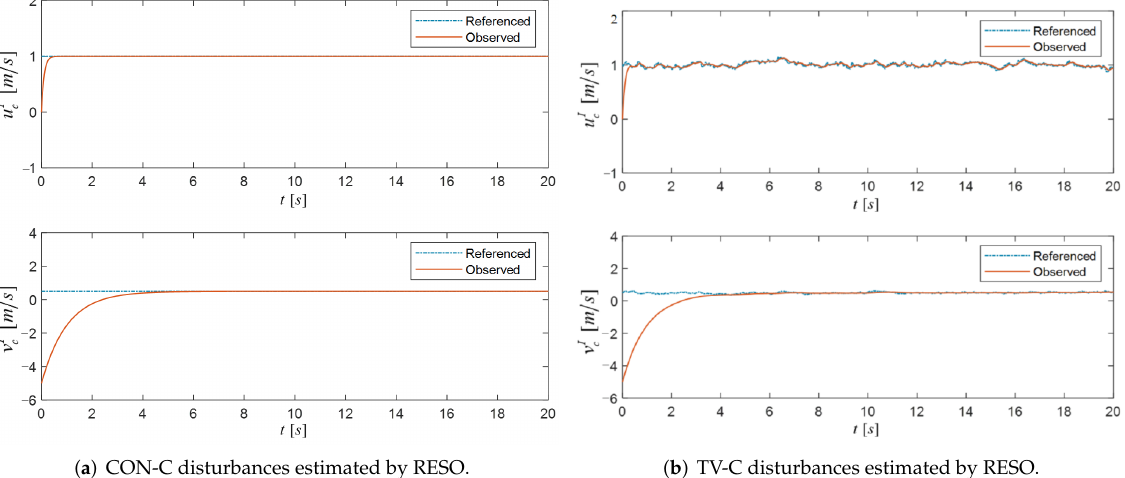
Figure 10. Unknown ocean current disturbances estimated by RESO.